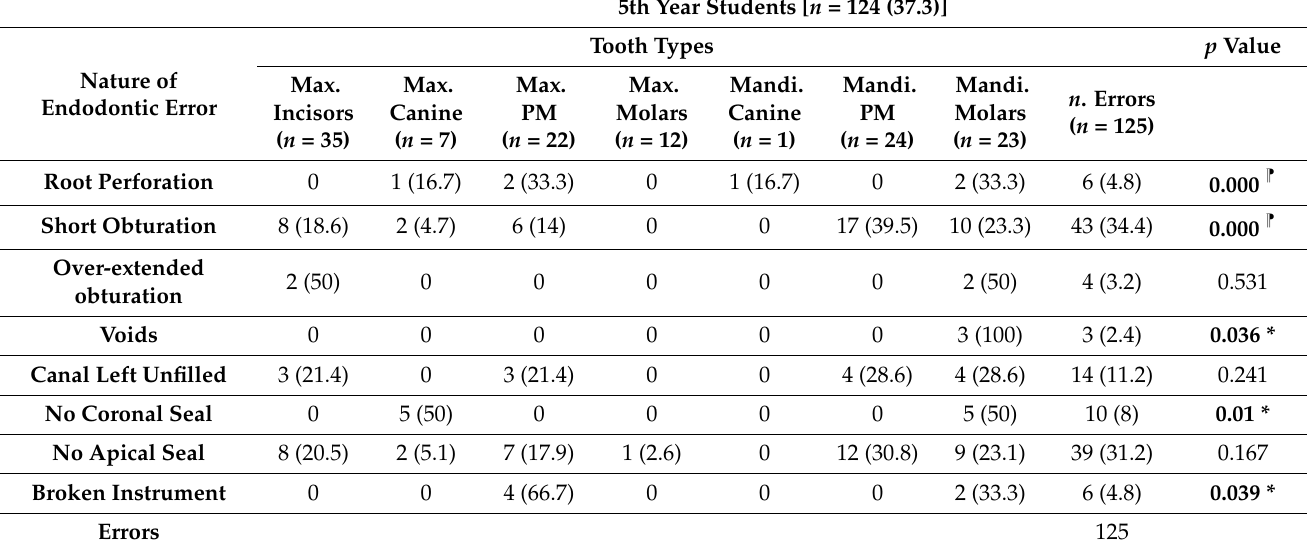
Table 3. The frequency and percentage of errors in RCF performed by 4th year students according to various tooth types. 4th Year Students [ n = 152 (45.8)] Table 4. The frequency and percentage of errors in RCF performed by 5th-year students according to various tooth types.